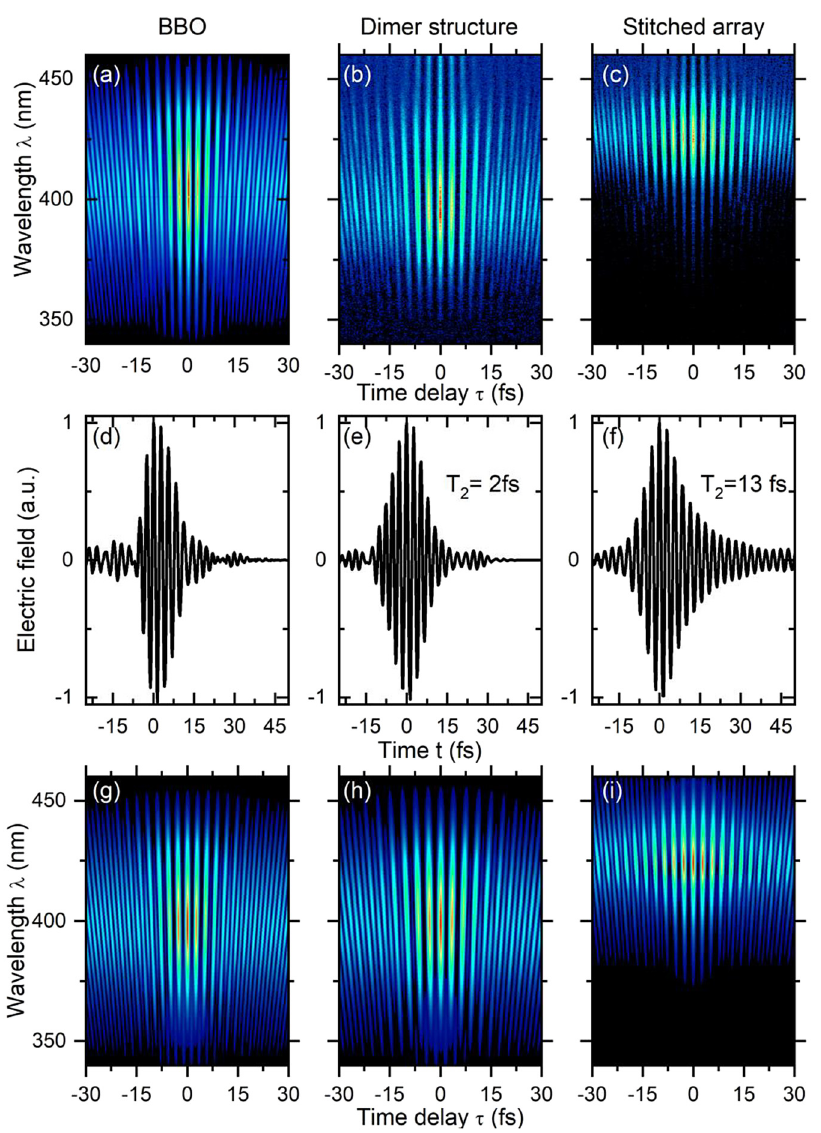
Figure 5: (a) – (c) Measured